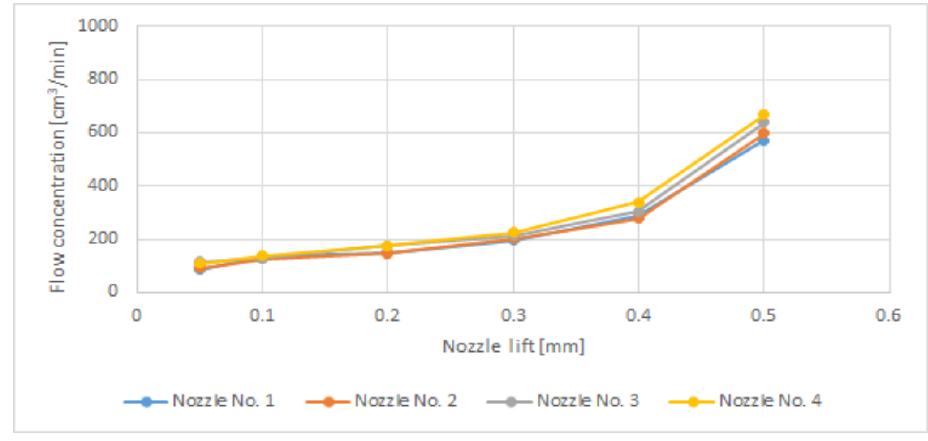
Figure 9. The flow after the test for SD2.